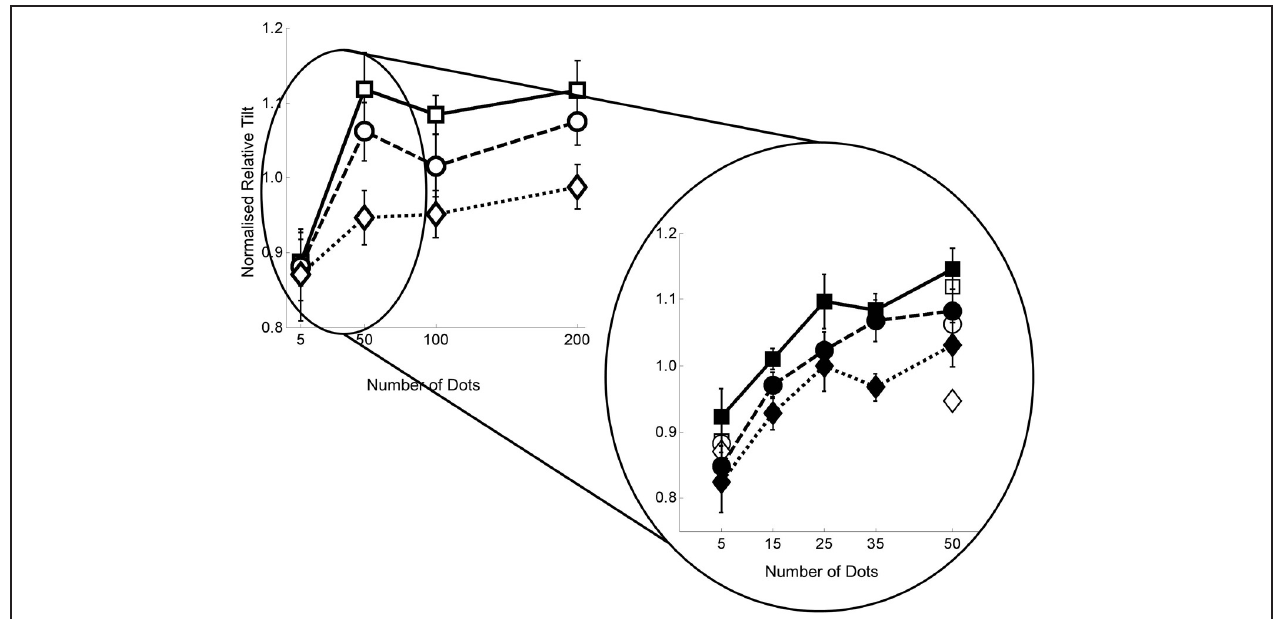
FIGURE 5 | Data from experiment 2 with number of dots per frame on the horizontal axis, and normalized relative tilt on the vertical axis. The three different plots on each graph represent the data for the three noise levels—squares with solid lines for no